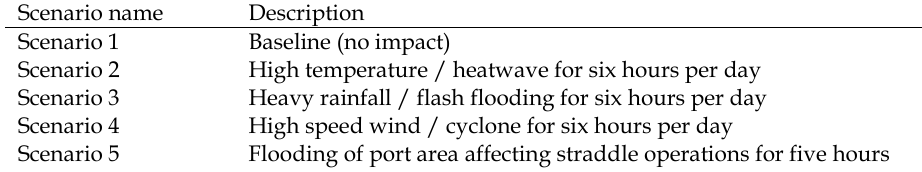
Table 7. Climate scenarios for the simulation